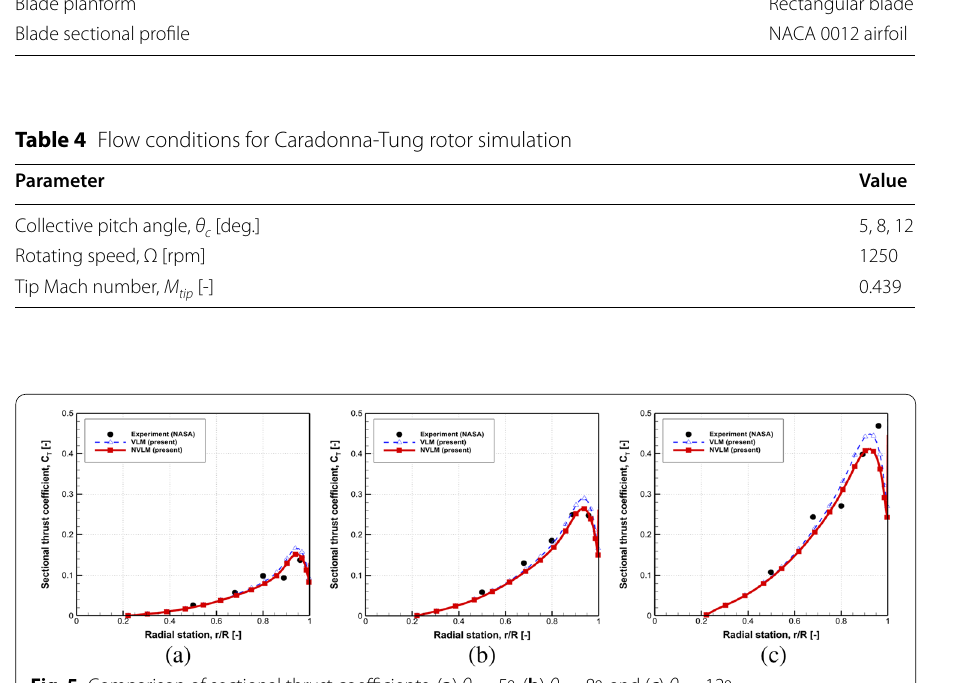
Fig. 5 Comparison of sectional thrust coefficients: ( a ) θ c